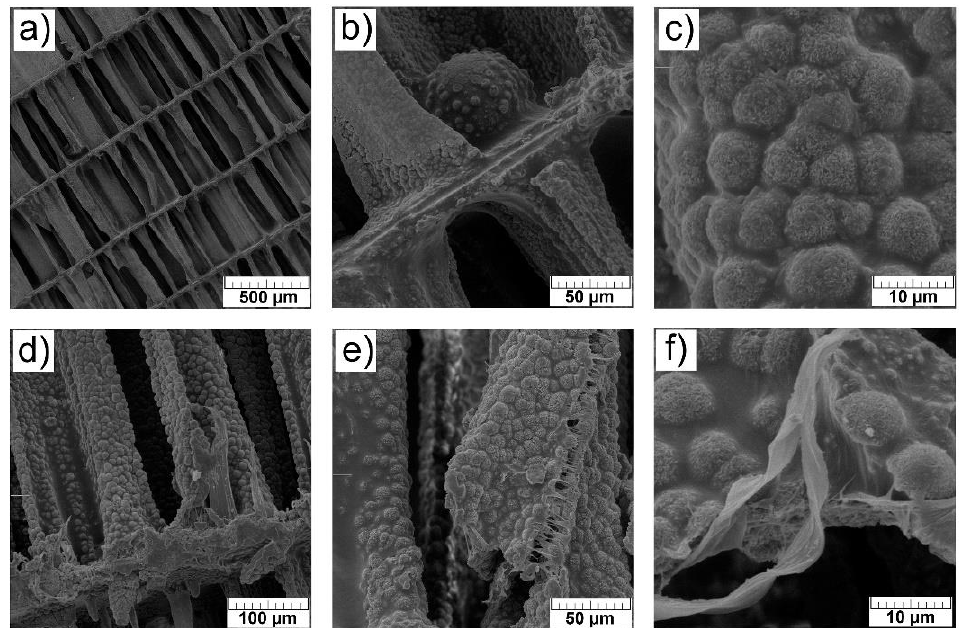
Figure 5. SEM micrographs of PCL coated 1-Mg-1-Sr-CaP scaffold. After polymer impregnation, the interconnectivity of the channels in the scaffold is maintained ( a , b , d ). The PCL layer on the irregularly shaped microspheres that resemble the cauliflower morphology is evident ( d , e ). The thin surface layer of PCL spread over the scaffold surface is visible on higher magnification ( c , f ).